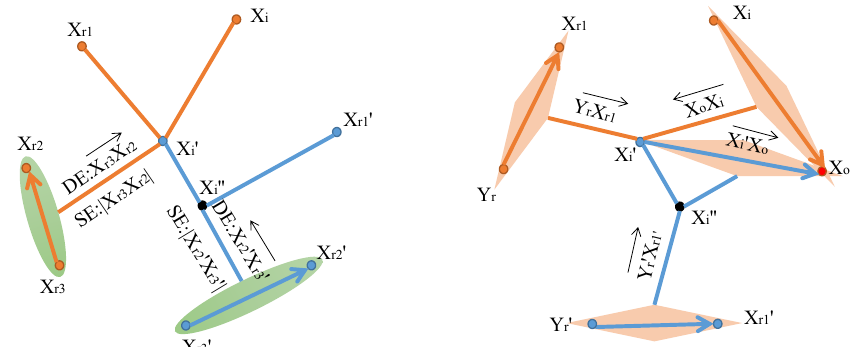
Figure 4. The population interaction networks of MHAs.